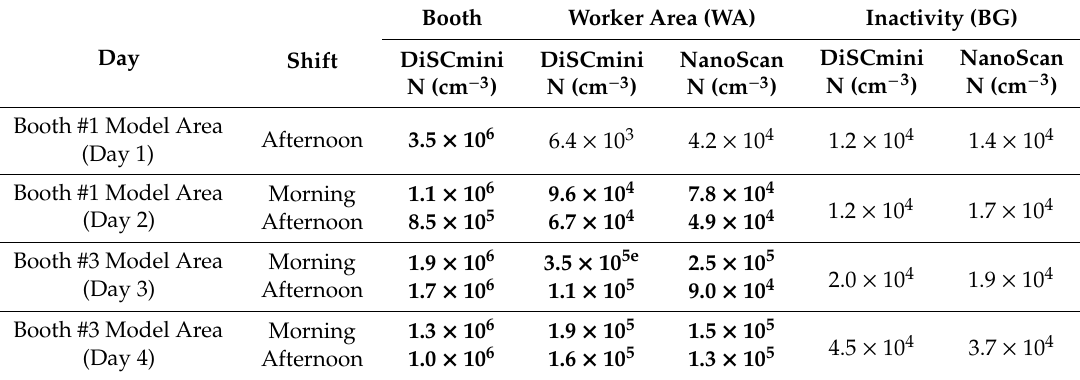
Table 1. Measured particle number concentration during the thermal spraying activity. Statistically significant increases are marked in